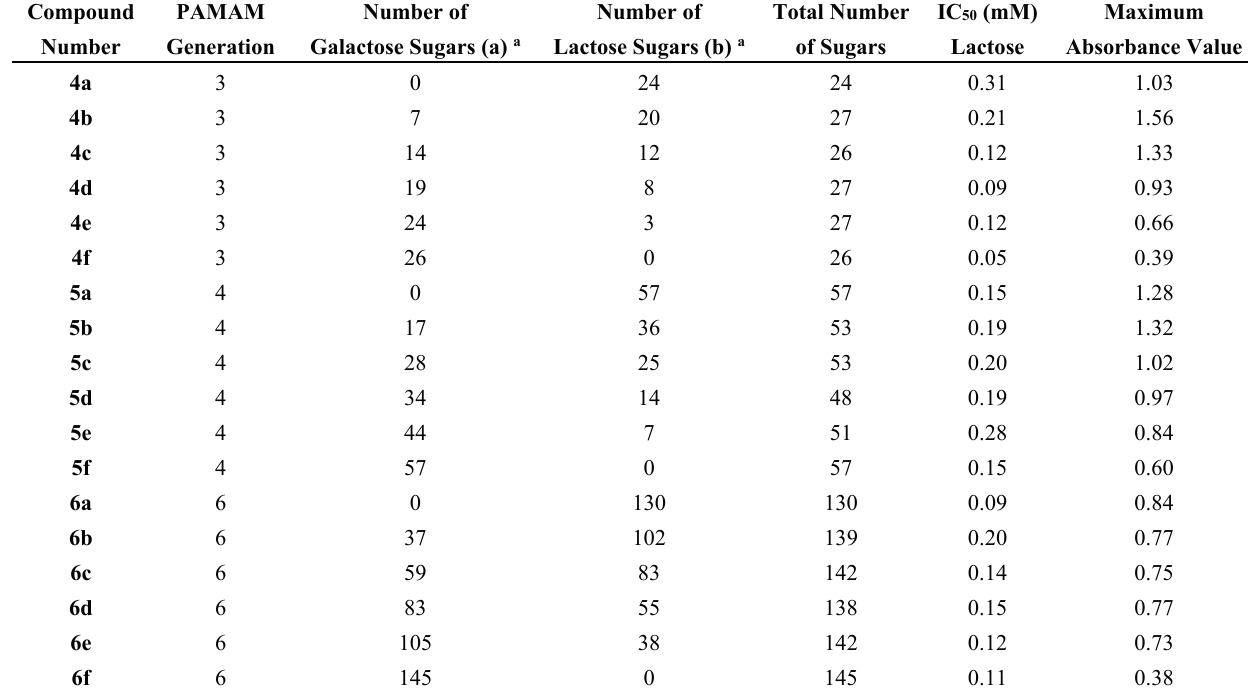
Table 1. Results for Compounds 4a – f , 5a – f and 6a – f with galectin-3.